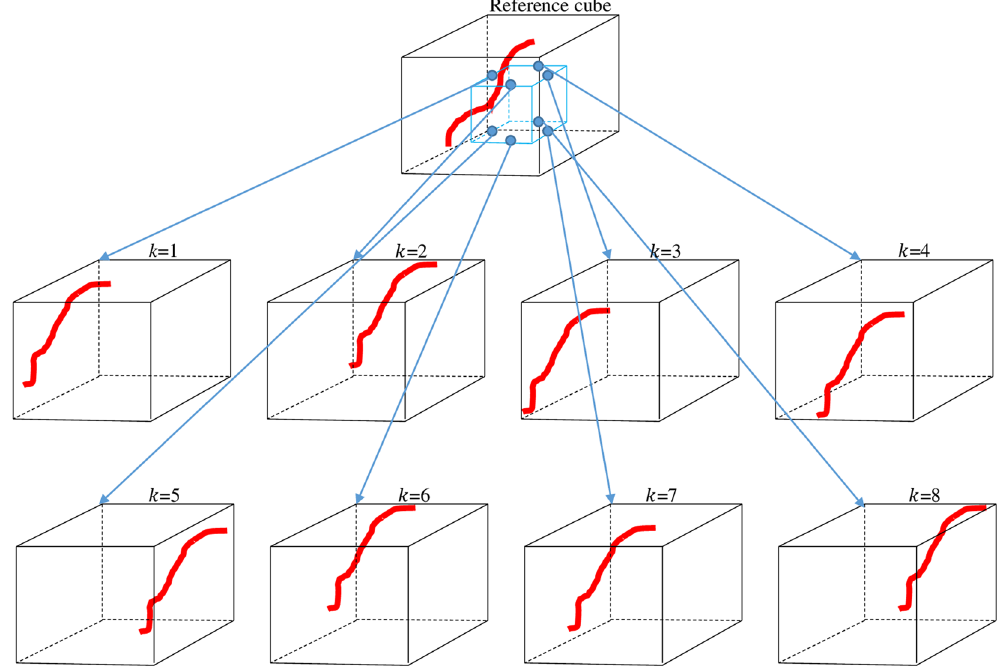
Figure 4. An illustration of the extraction of neighboring cubes ( K = 8) from the small neighborhood (i.e., small blue block in the top of figure) around the center of the reference